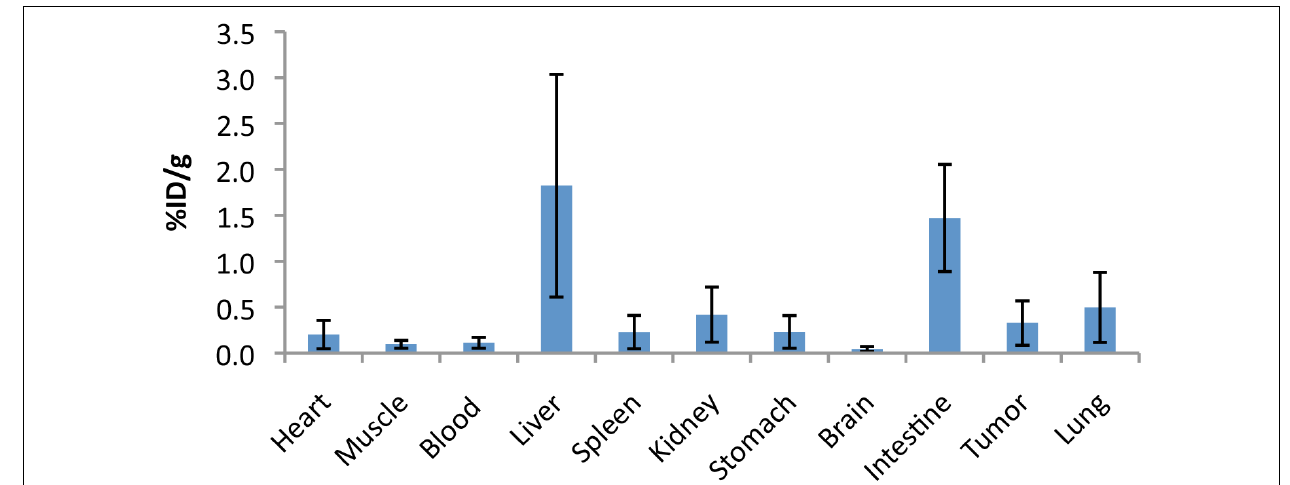
FIGURE 5 | Uptake (% injection dose/g tissue) of the 18 F-COX2 probe 13 in non-fasted tumor-bearing mice ( n =